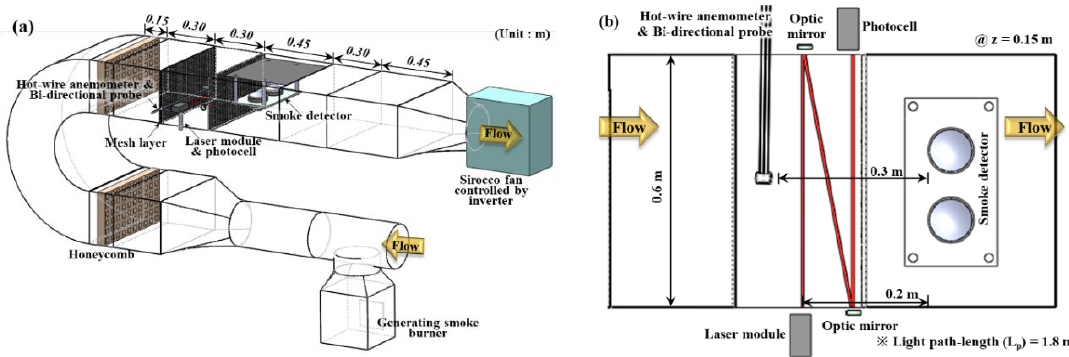
Figure 2. Schematics of ( a ) Fire Detector Evaluator (FDE) and ( b ) test section for measuring input parameters required in the numerical models of a smoke detector [16].